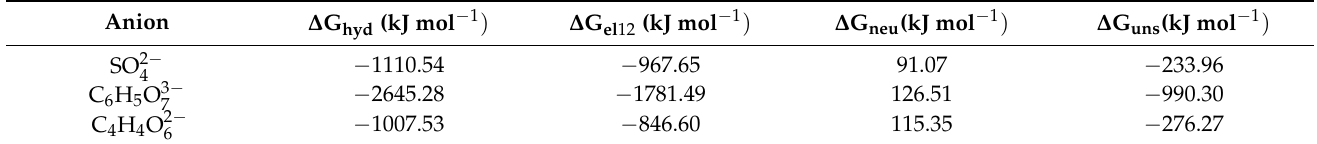
Table 1. Gibbs free energy of hydration ( ∆ G hyd ), Gibbs free energy of neutral interactions between anions and water ( ∆ G neu ), Gibbs free energy of electrostatic interaction in hydration shell and in water shell around itself ( ∆ G el12 ), and nonsymmetrical Gibbs free energy ( ∆ G uns ).